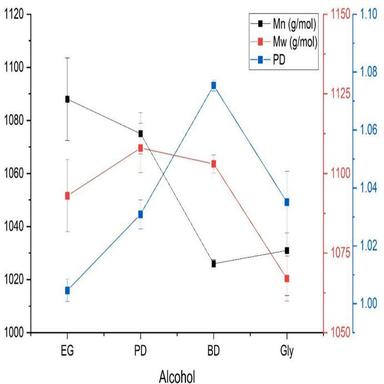
Effect of different alcohols on the Mn, Mw, and PD of PHB-diol products. Results are presented as the mean values of two independent replicates. The error bars represent the standard deviations of the mean values.